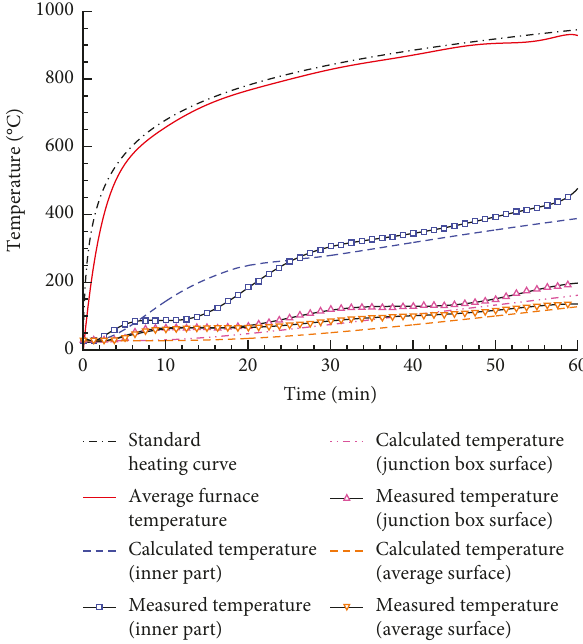
Figure 20: Measured temperatures compared to the calculated values in Test